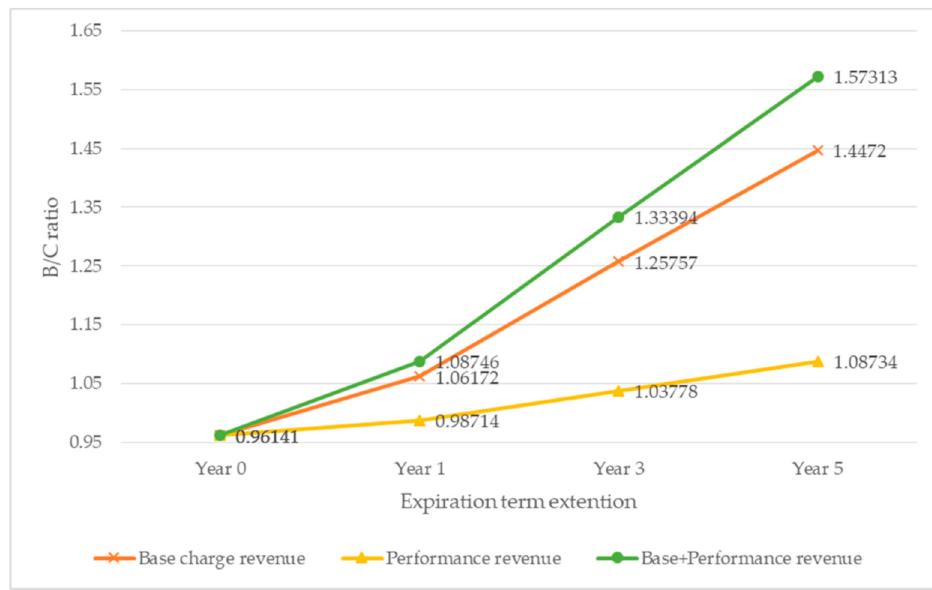
Figure 10. B/C changes owing to benefits from the extension of the expiration